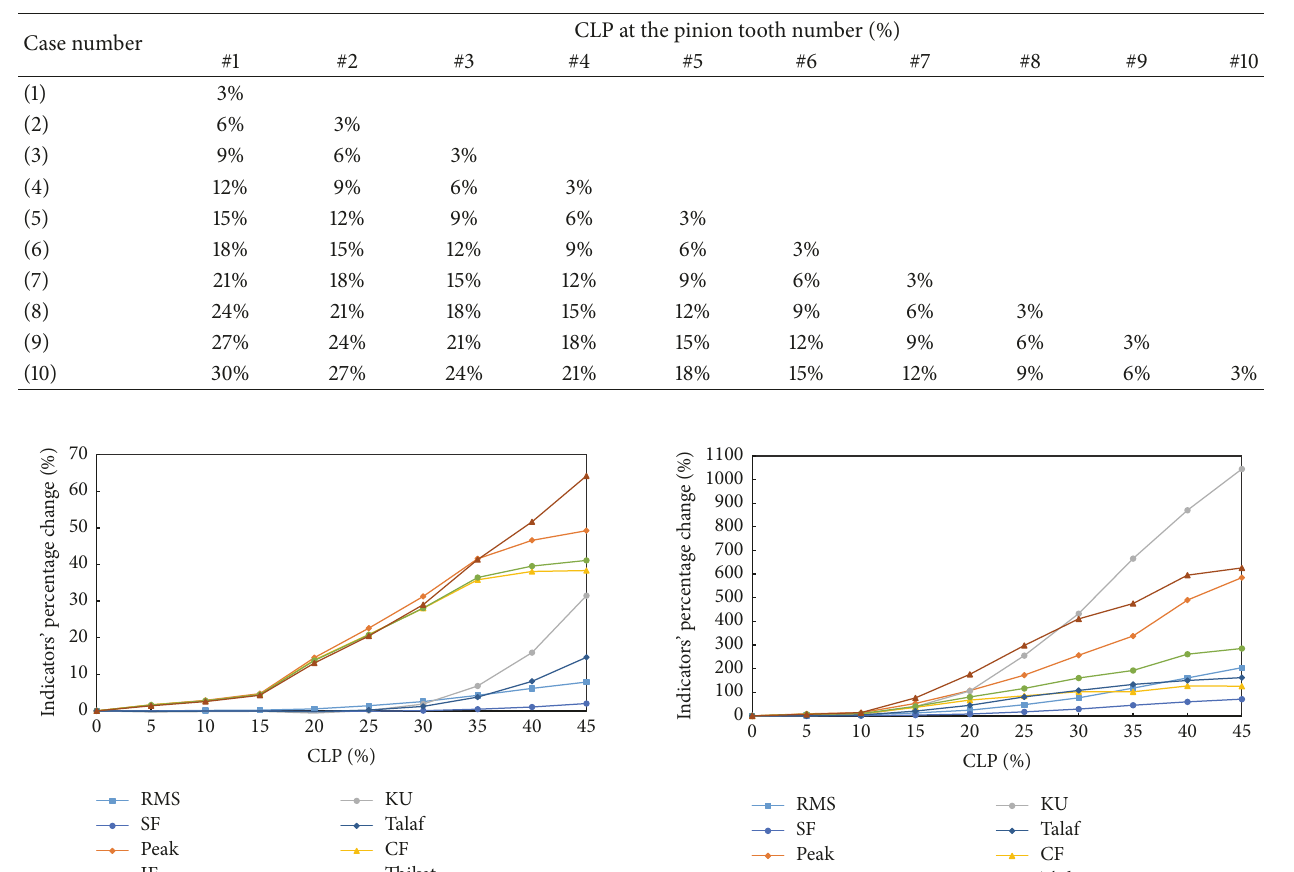
Table 7: Cases for the fourth scenario with different crack locations and lengths.